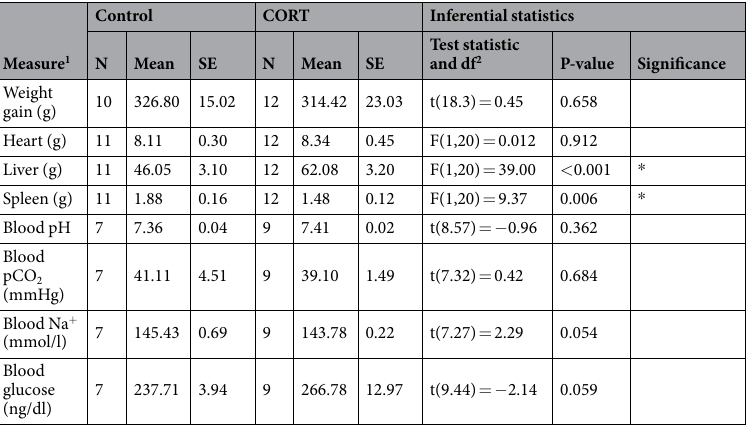
Table 2. Effects of the experimental treatment on anatomy and blood physiology. Notes: 1 With the exception of Weight gain, which was measured between days 11 and 17, all measures were taken at the end of the experiment on day 17. 2 For Weight gain, pH, pCO2, Na + and Glucose the test was a two-sample t-test; for Heart, Liver and Spleen, the test was an ANCOVA with weight on day 17 included as the covariate. * Indicates a P-value ≤